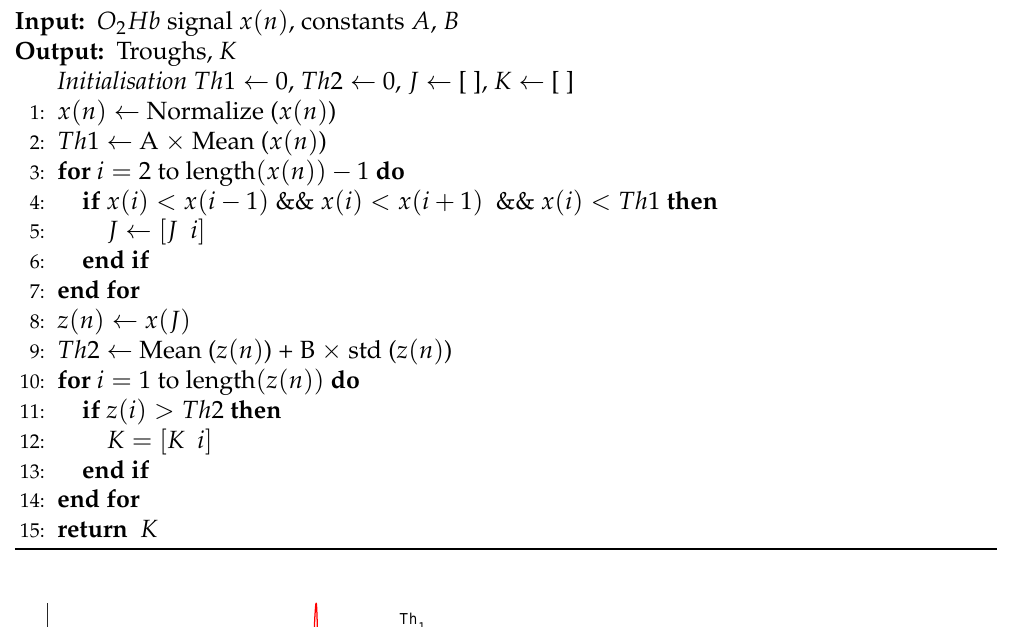
Algorithm 1 Localization of O 2 Hb signal troughs